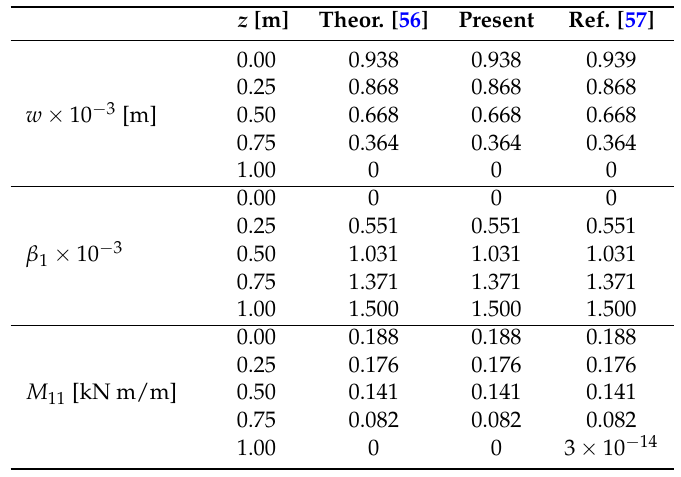
Table 4. Simply supported circular plate subject to uniform pressure. Comparison of present results for w , β 1 , and M 11 at different locations z , for cp = 7, p = 4. Theoretical results from [56], reference results from [57].